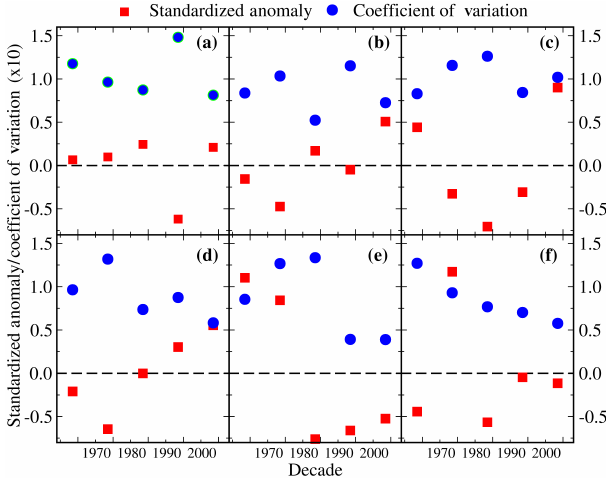
Figure 1. Climatic change may manifest itself as changes in the statistics of streamflow, and such changes can have important im- plications for water resource management. A recent study searched for trends in the streamflow within six basins of northern Canada; results are shown above. Each box represents a specific basin: (a) Bering Sea; (b) western Arctic Ocean; (c) western Hudson and James Bay; (d) eastern Hudson and James Bay; (e) eastern Arctic Ocean (Hudson Strait/Ungava Bay); and (f) Labrador Sea. Within each basin, after determining a mean and standard deviation from the 50 years of data, the flow for each year was standardized, and the average standardized streamflow for each decade of interest was computed and plotted above as a red square. Similarly, the co- efficient of variation of total river discharge for each decade was computed from the mean and standard deviation of discharge within that decade and plotted as a blue circle. (Note that values of the co- efficient of variation have been multiplied by 10.) The streamflow amounts in the different basins clearly show strong decadal variabil- ity; however, they lack a clear trend. (Contact: Stephen